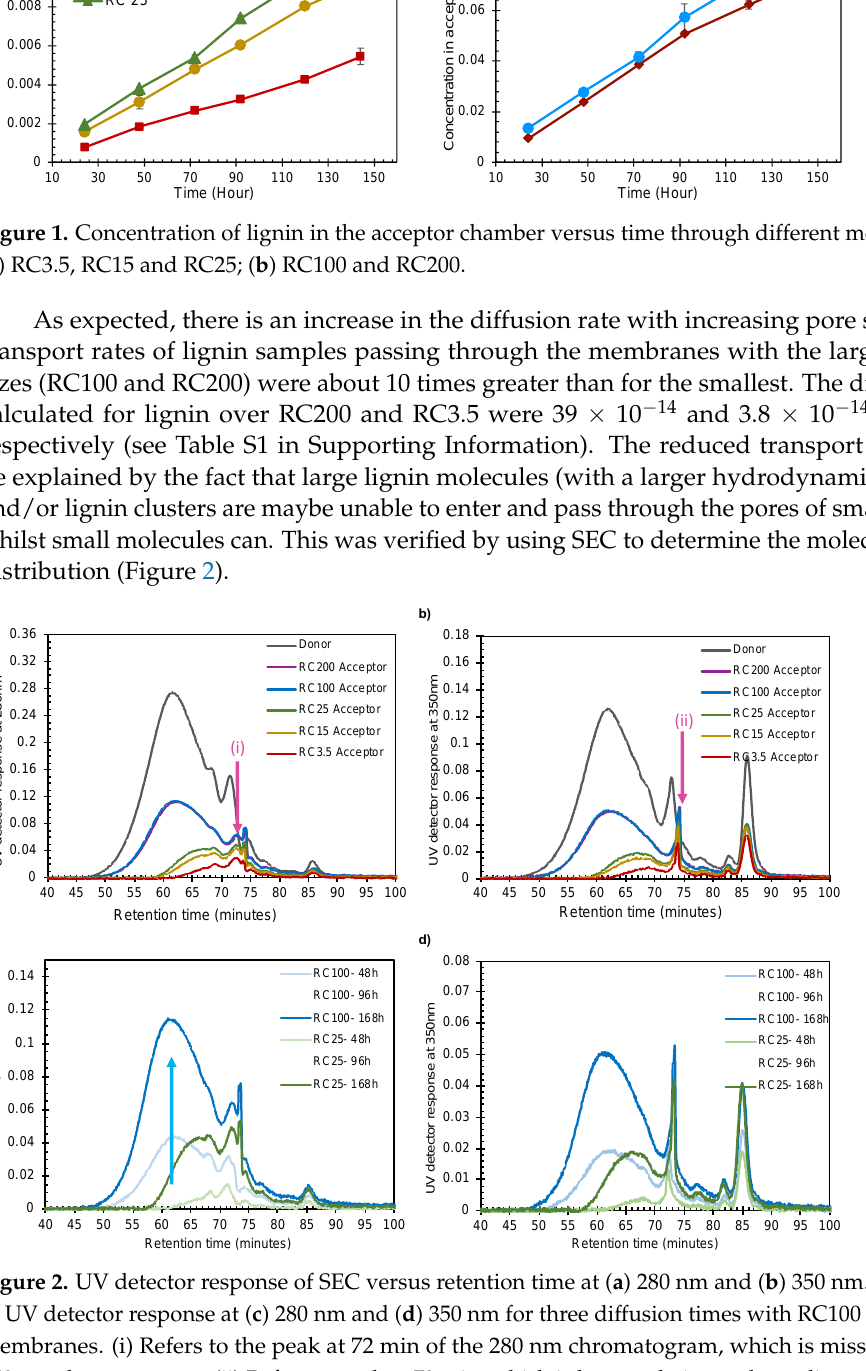
crease with time (Figure 1). The curve does not exhibit any abrupt changes with time,